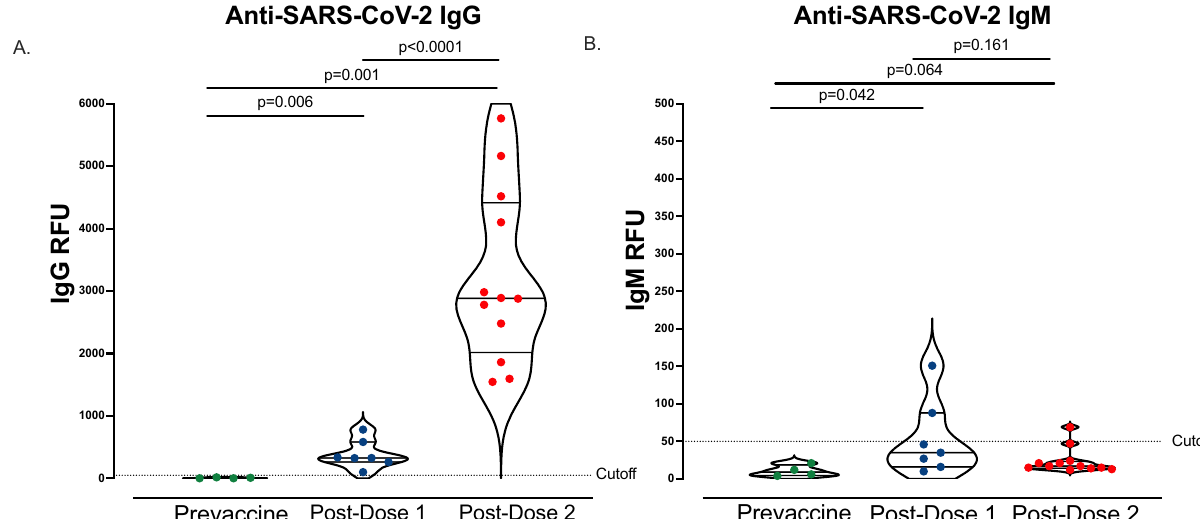
Fig.1|Anti-SARS-CoV-2IgGandIgMantibodyresponsesfollowingvaccination. A Maternalplasmaanti-SARS-CoV-2RBD/NIgGantibodyrelative fl uorescenceunits (RFU) levels prior to vaccination ( n =4), 3 – 4 weeks post-dose 1 ( n =7), and 4 – 8 weeks post-dose 2 ( n =12). B Maternal plasma anti-SARS-CoV-2 RBD/N IgM